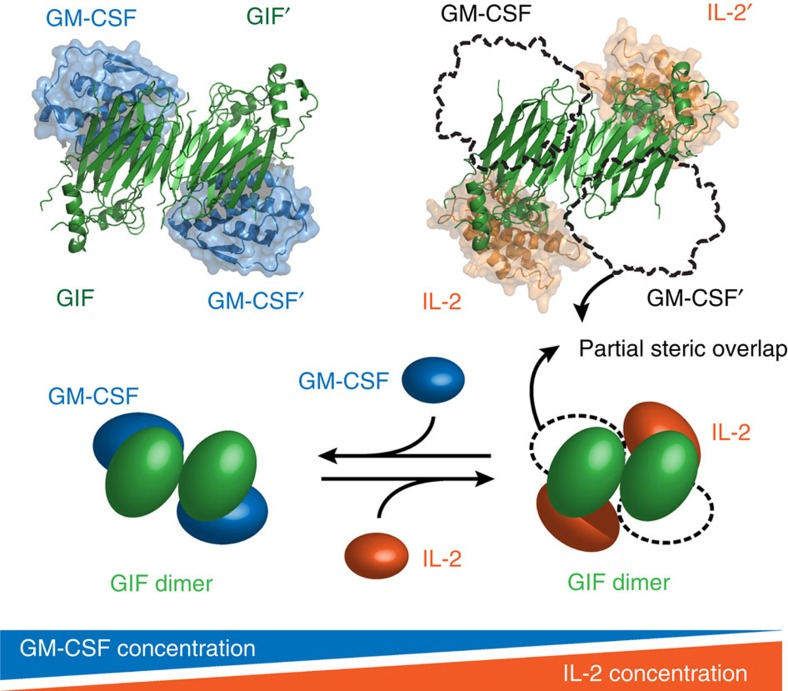
Schematic mechanistic recapitulation of the two possible GIF–cytokine complexes.GM-CSF (dark blue) and IL-2 (orange) have partially overlapping binding sites on GIF (dark green). In the presence of an excess of IL-2, the GIF:GM-CSF complex switches to a GIF:IL-2 complex, and vice versa.